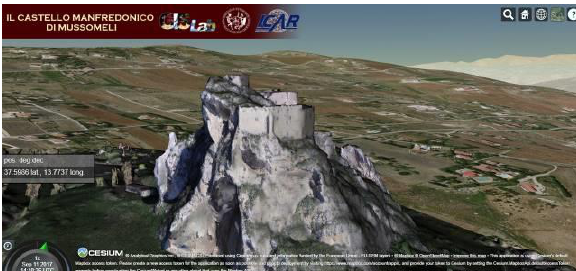
Figure 8. The virtual navigation in the model generated with the open-source solution